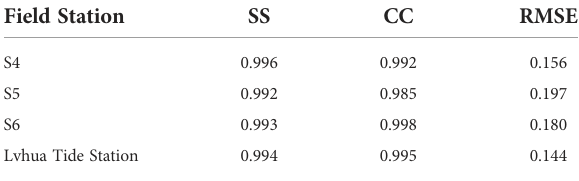
TABLE 2 The model-data comparisons of tidal elevation.